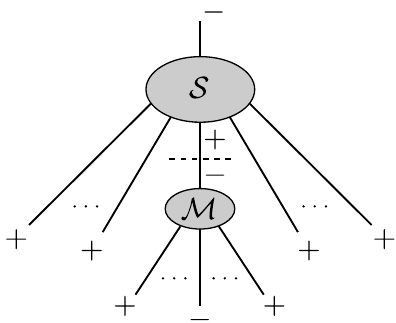
Figure 3 . A pole contribution in the recursion of the MHV static-patch amplitude S (1 + , . . . , i − , . . . , n + ; − ) via eq. (4.19). The amplitude decomposes into a Minkowski S-matrix MHV amplitude, times a simpler static-patch amplitude of the type S (+ , . . . , +; − )